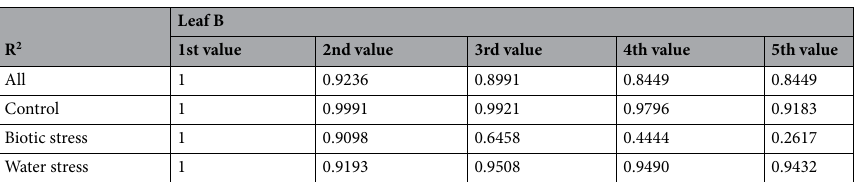
Table 5. Correlation coefficients (R 2 ) between measured and estimated biophoton emission intensities (count/ min) on Leaf B in each time step using the logarithmic slope parametrization method based on calculations of Leaf A.